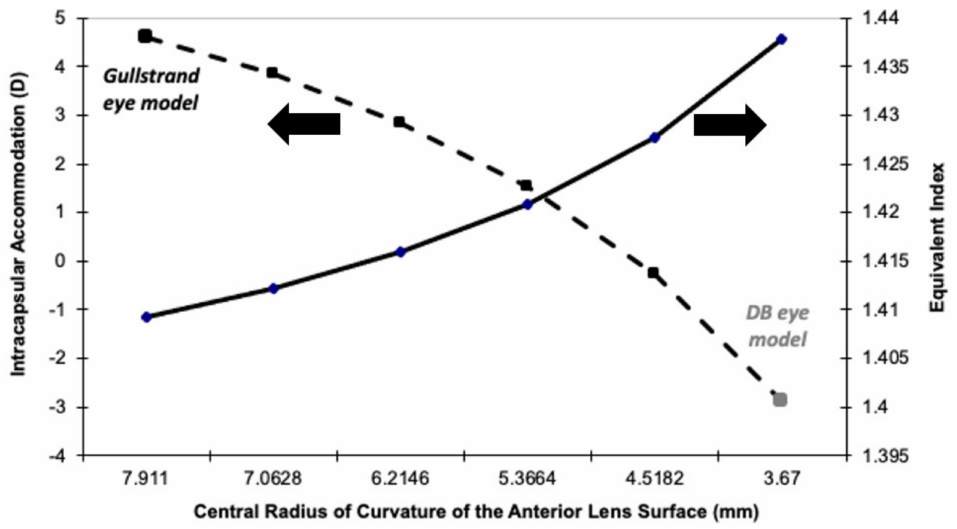
Figure 2. Equivalent refractive index ( Y -axis right) of the relaxed eye model, and the intracapsular accommodation ( Y -axis left) for a model eye, for which the anterior radii of curvature of the nucleus changes linearly from the one proposed by Gullstrand more than a century ago (left part of the X -axis) to the DB eye model (right part of the X -axis) generated with data obtained a few years ago.